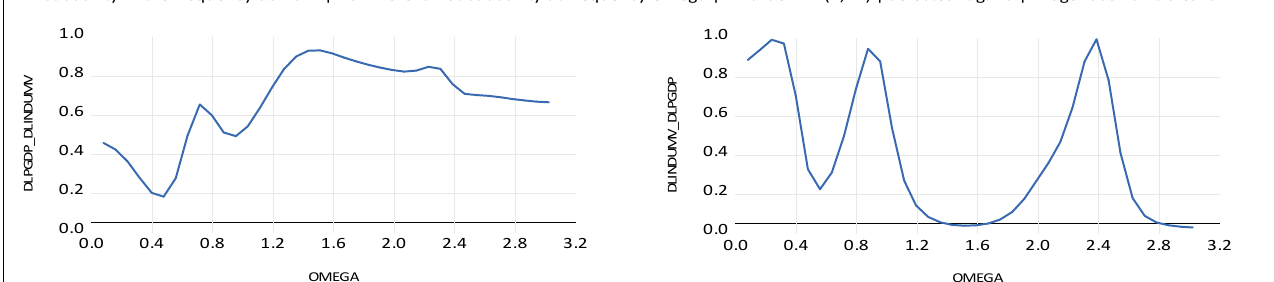
Figure 6: Causality from DLINDUMV → DLPGDP in the left and from DLPGDP → DLINDUMV in the right.